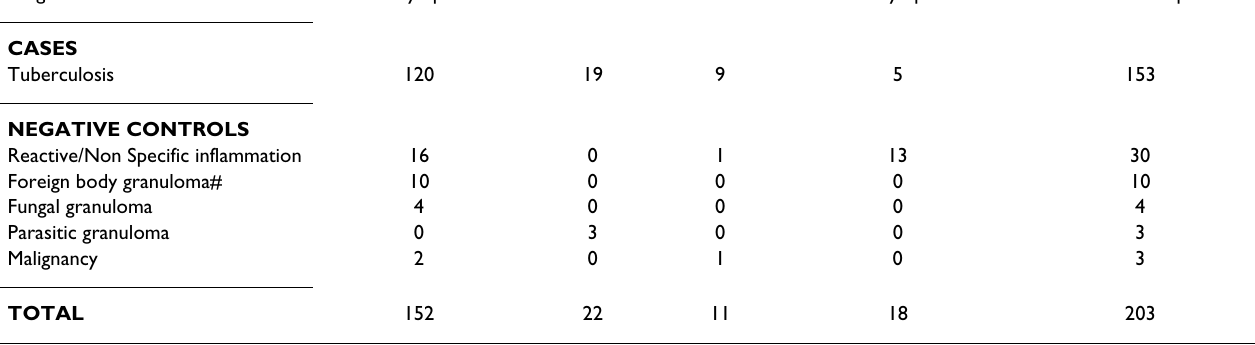
Table 1: Diagnostic categories of specimens tested.